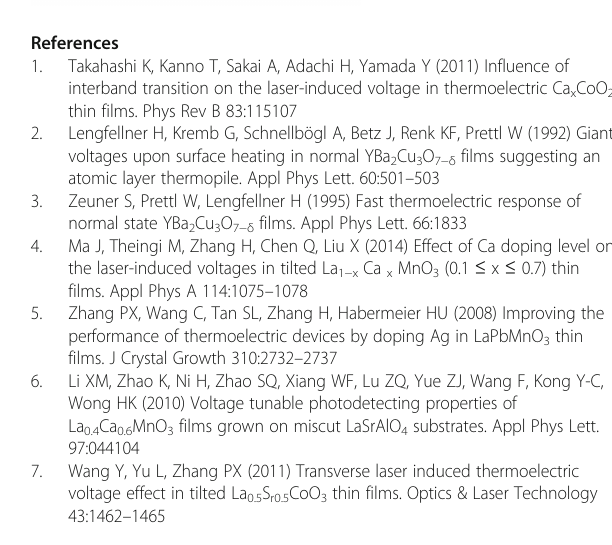
Fig. 5 Voltage responses of bare BiCuSeO upon a 308 nm pulsed laser illumination before and after connecting a 7.6 K Ω resistor in